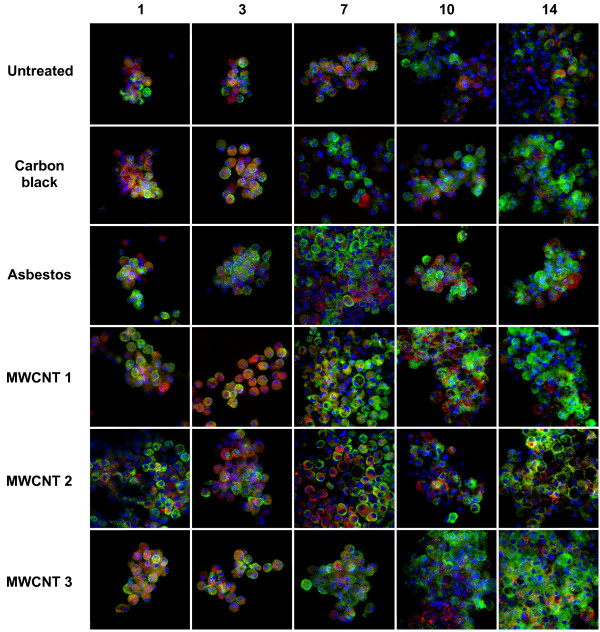
Early induction of TNF-α expression followed by late induction of mannose receptor (MR) in 3D cultures. Cells were exposed to 0.5 μg/ml (0.38 μg/cm2) of particulates. After 1, 3, 7, 10 and 14 days, cells were incubated with Brefeldin A for 6 hrs, fixed in situ and co-immunostained for TNF-α (red), MR (green), and counterstained with DAPI (blue nuclear fluorescence). A three-day exposure to asbestos or MWCNTs resulted in an increase in TNF-α expression. Prolonged exposure to all nanomaterials resulted in an increase in MR expression. Samples were analyzed by confocal microscopy using the appropriate filters. Photographs are representative of Z-stacks of three individual samples. Magnification: 400×.